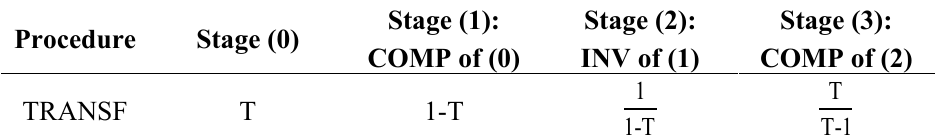
Table 2. Another combination of complementary-inverse transformation for a voltage-mode network. Stage Procedure Stage (0)